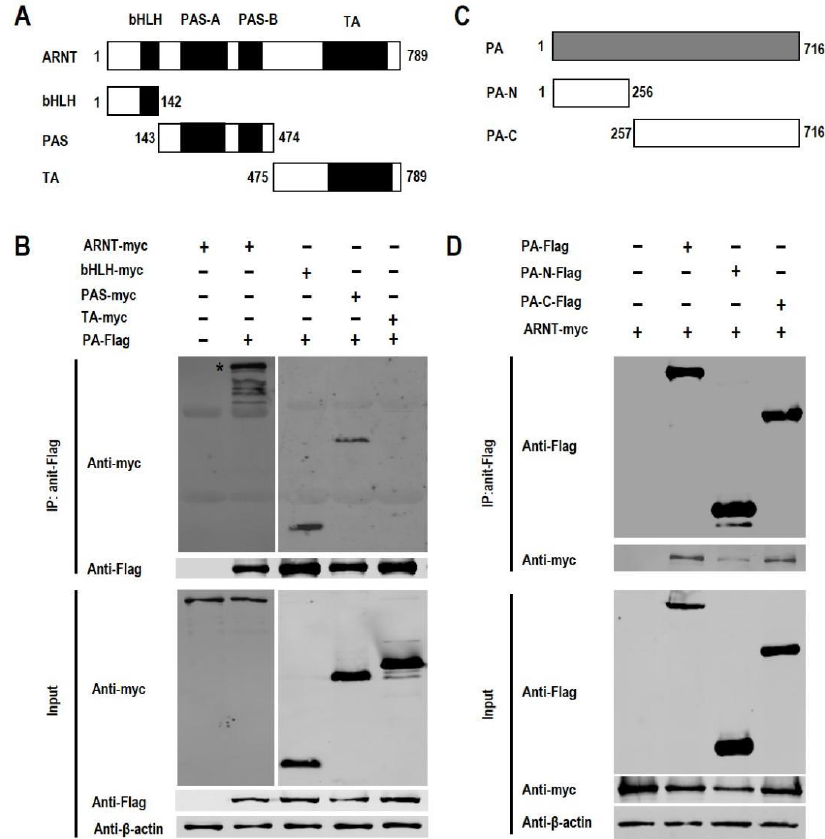
Figure 2. Interaction between subdomains or domains of ARNT and PA in 293T cells. ( A ) Schematic diagram of the full-length ARNT and ARNT mutants tested in this study. ( B ) Co-immunoprecipitation analysis of the interaction between PA and ARNT mutants. 293T cells were co-transfected with pCAGGS-PA-Flag and different c-Myc-tagged ARNT mutants. At 48 h p.t., cell lysates were immuno- precipitated with an anti-Flag antibody followed by Western blotting with anti-c-Myc and anti-Flag antibodies. ( C ) Schematic diagram of the full-length PA and PA mutants. ( D ) Co-immunoprecipitation analysis of the interaction between PA mutants and ARNT. 293T cells were co-transfected with pCAGGS-ARNT-c-Myc and different Flag-tagged PA mutants. At 48 h p.t., cell lysates were immuno- precipitated with an anti-Flag antibody followed by Western blotting analysis with anti-c-Myc and anti-Flag antibodies. *, the target